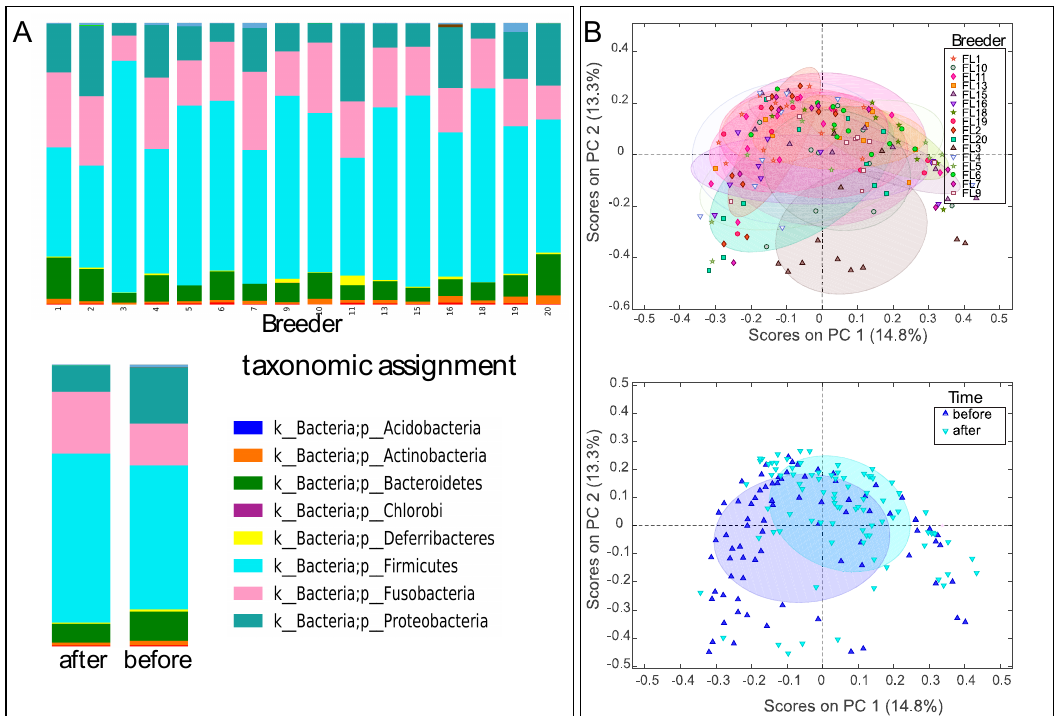
Figure 1. Phylum-level distribution ( A ) and Bray–Curtis diversity ( B ) of the microbiota. Upper panels for A represent team distributions, while lower panels represent after and before the race. The 50% confidence level is labelled for Bray–Curtis distribution. The beta-diversity plots were generated using principal coordinates analysis (PCoA) ordination.